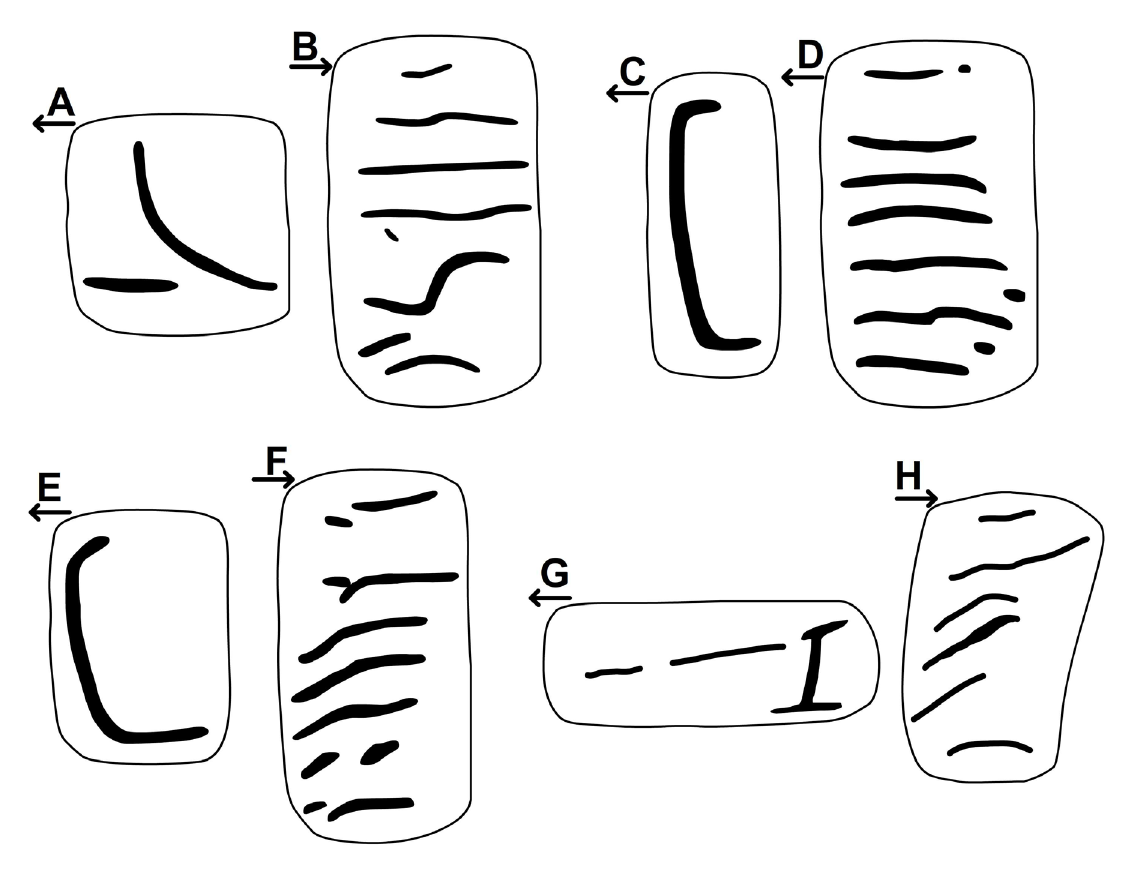
Fig. 32. Parietal (A, C, E, G) and palatal (B, D, F, H) plication of species of Hunyadiscus Páll- Gergely, 2016 and Naggsia Páll-Gergely & Muratov, 2016. A–B . Hunyadiscus saurini Páll-Gergely, 2016, paratypes from the type locality (UF 448579). C–D . H. tigrina sp. nov., paratype (UF